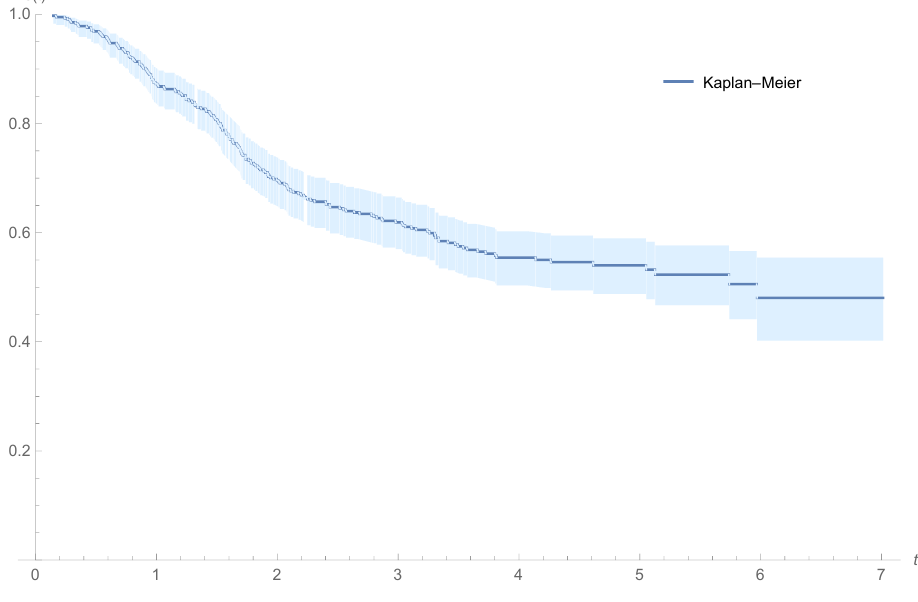
Figure 5. Kaplan–Meier curve for the melanoma